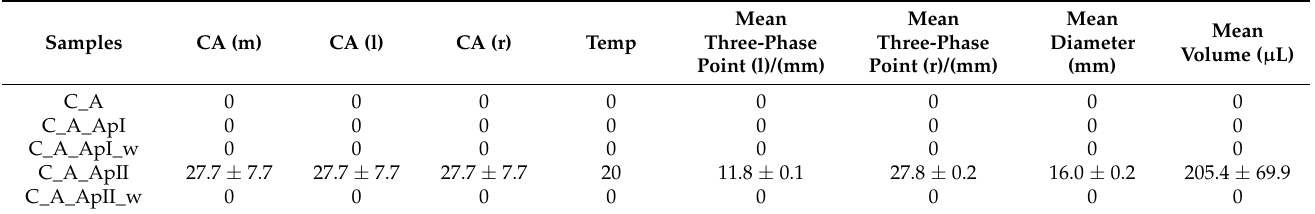
Table 4. Results of the contact angle (CA) and standard deviations of the contact angle for the samples in satin